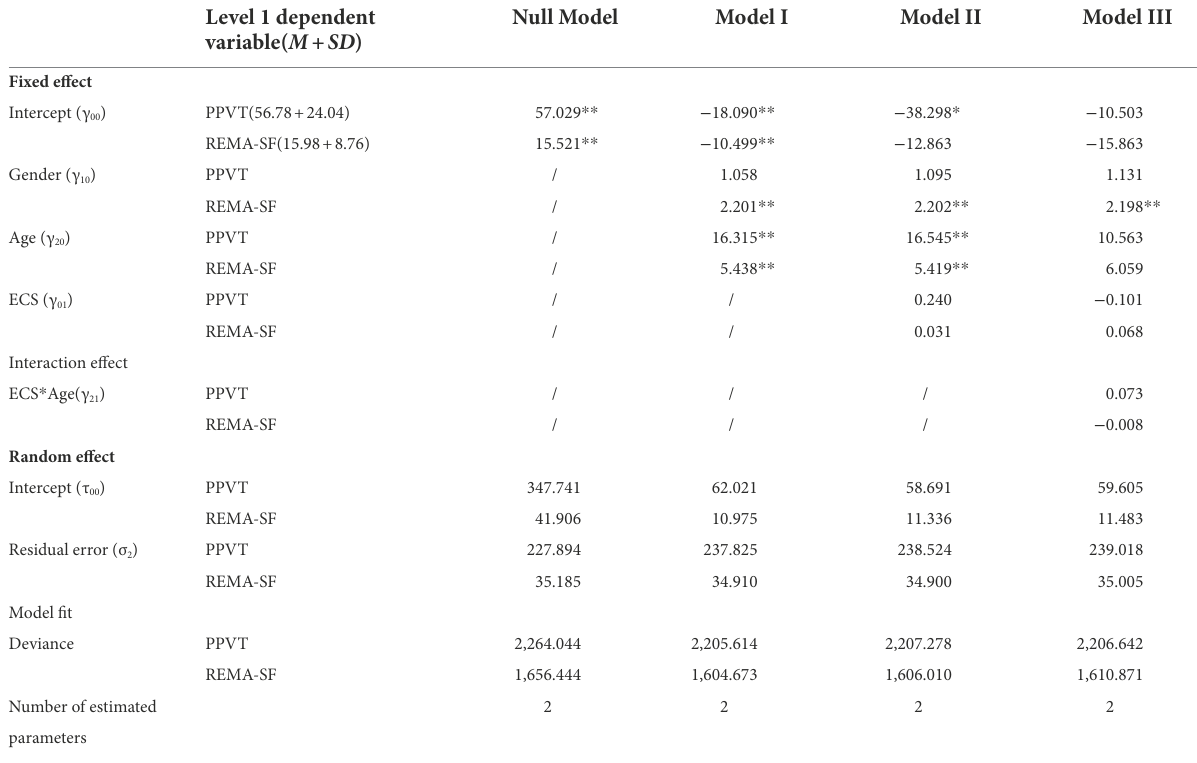
TABLE 5 Analysis results of two-level linear